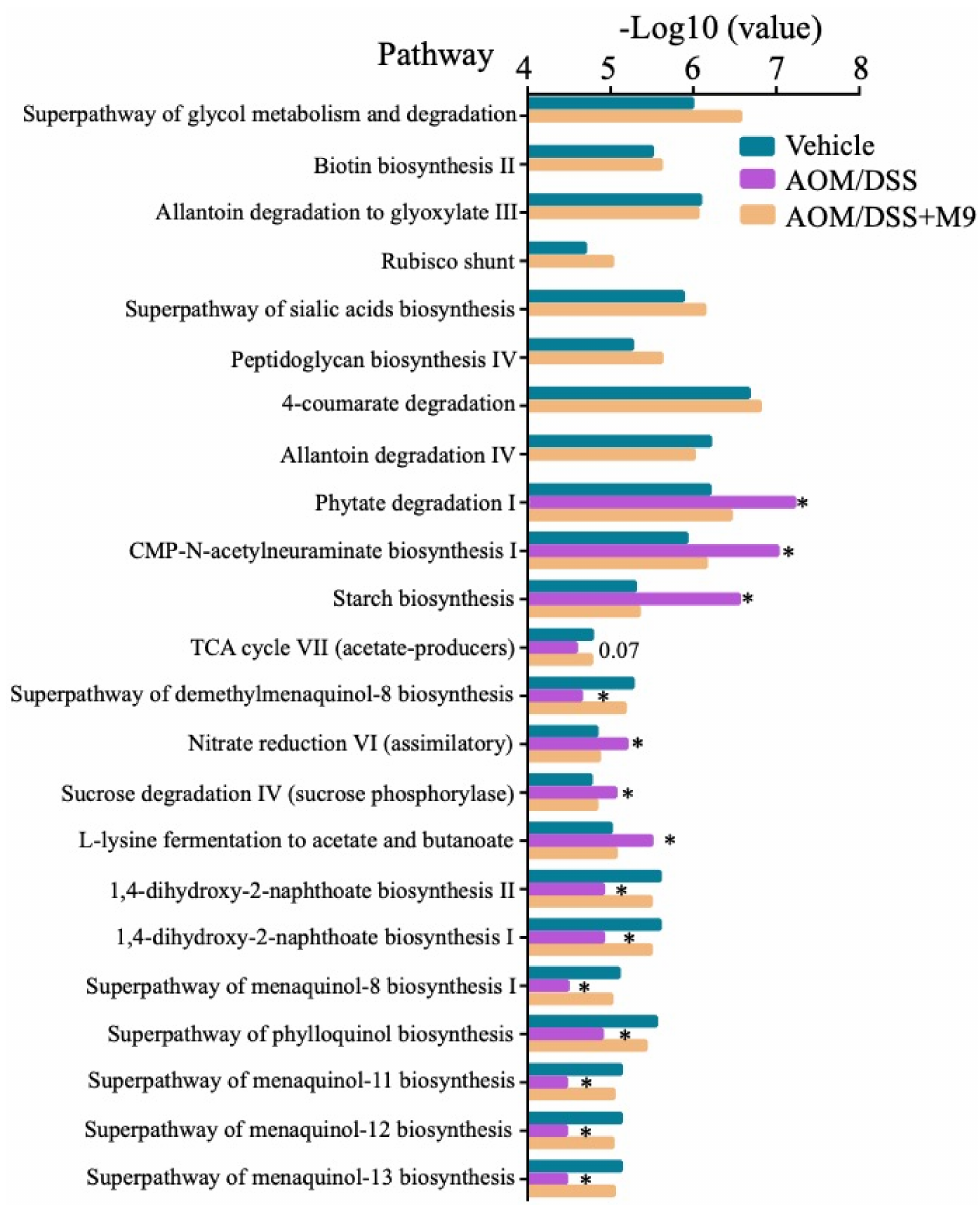
Figure 6. The difference in metabolic pathways among three groups on week 17. * p < 0.05 represents the difference between AOM/DSS and Probio-M9 groups. n = 3 in vehicle and AOM/DSS groups and n = 4 in AOM/DSS+M9 group; CMP: Cytosine nucleotides, TCA: the tricarboxylic acid